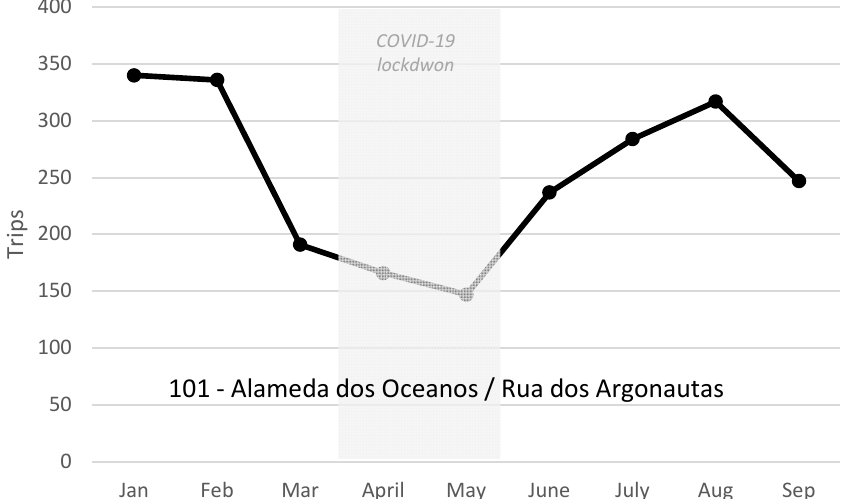
Figure 12. Trips with origin in the busiest station identified in 2018.